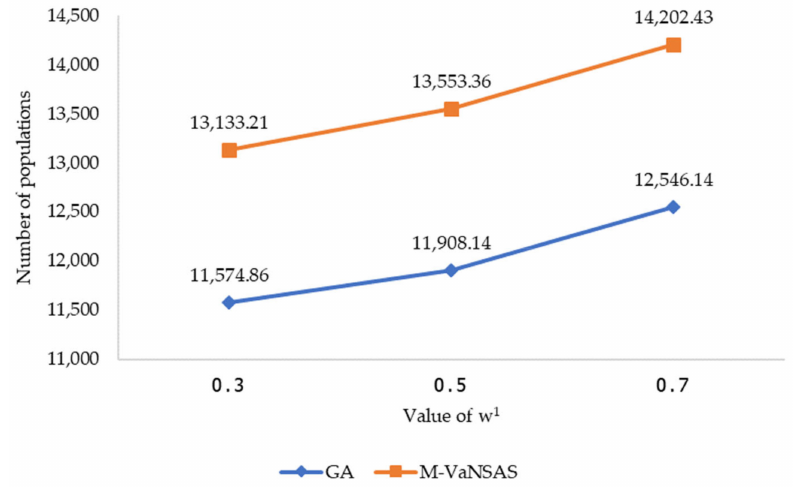
Figure 5. Effect of weight w 1 on the number of populations covered by the ambulances within R 1 traveling time (Cov-R 1 ) given by different solution approaches.